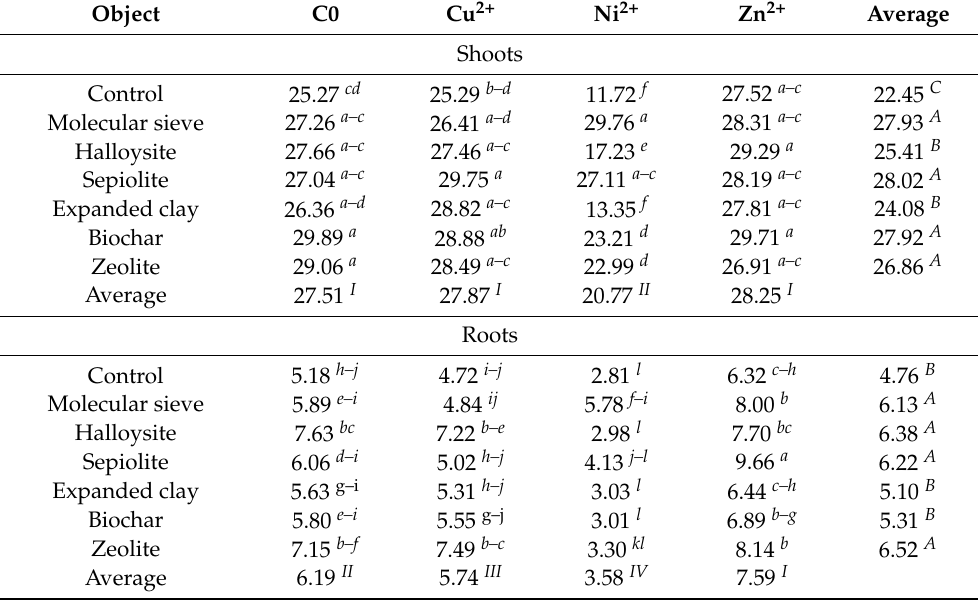
Table 4. The yield of Helianthus annuus L. (d.m. g · pot − 1 ). Object C0 Cu 2+ Ni 2+ Zn 2+ Average